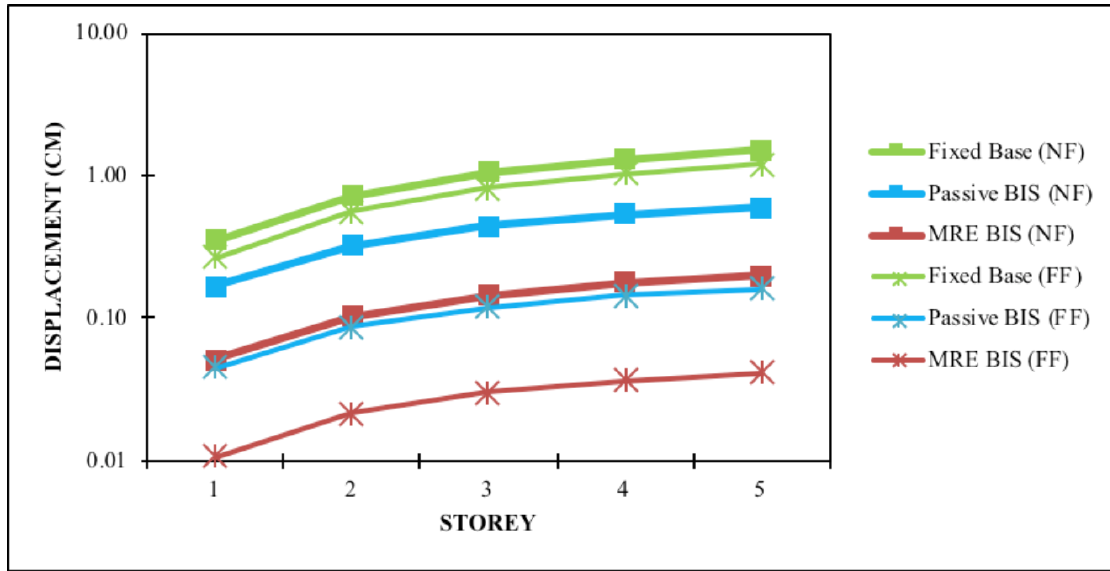
Figure 7. Peak displacements relative to base, Imperial Valley